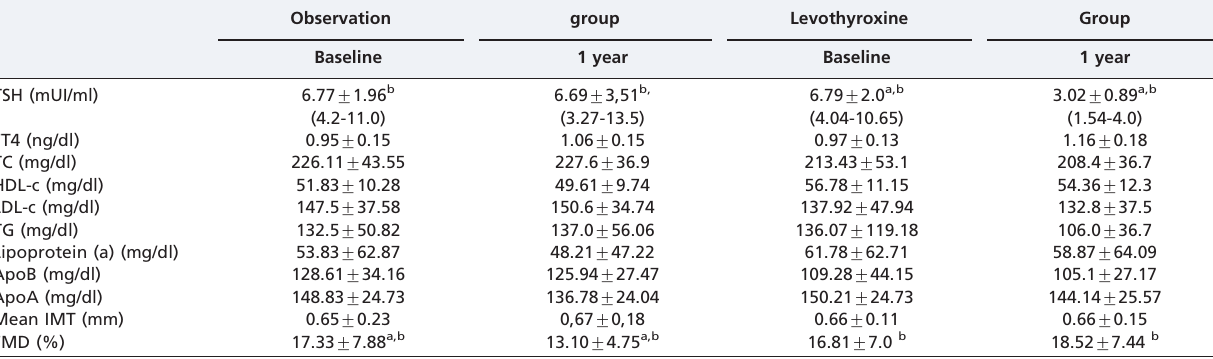
Table 2 - Initial (baseline) and final (after one year) results of the levothyroxine-treated and observation